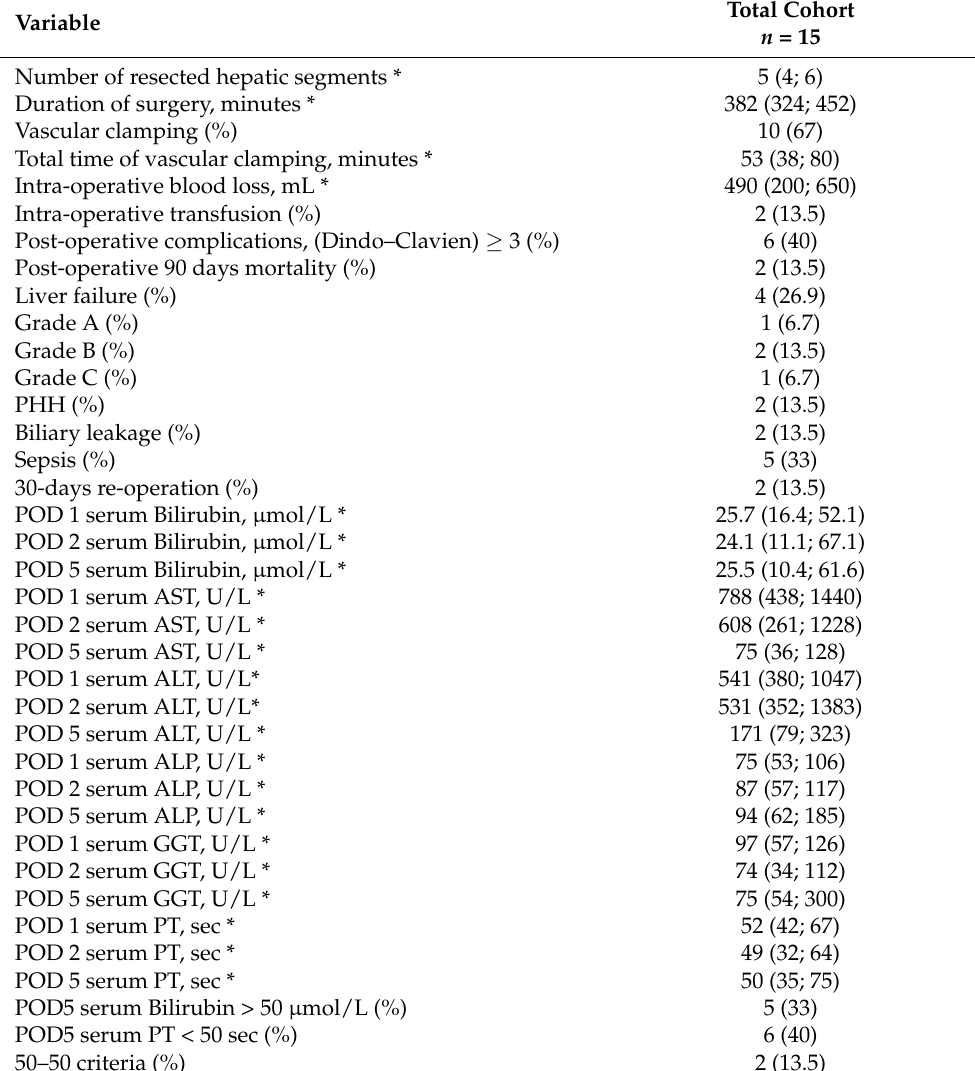
Table 2. Descriptive analysis of intra-operative and post-operative